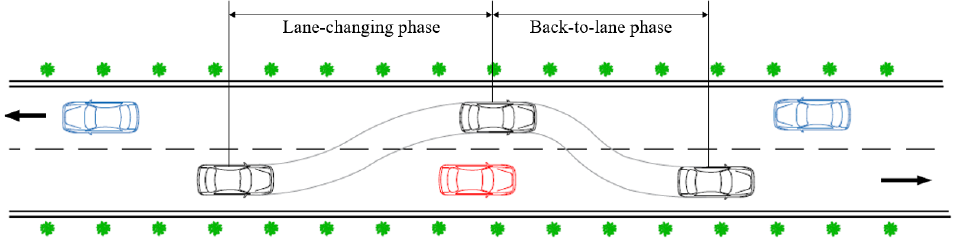
Figure 1. Two phases of overtaking.